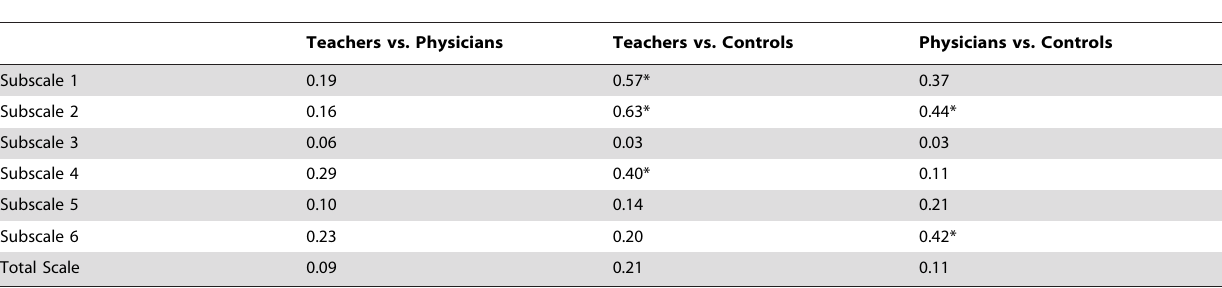
Table 8. Effect sizes (Cohen’s d) of stigma responses between